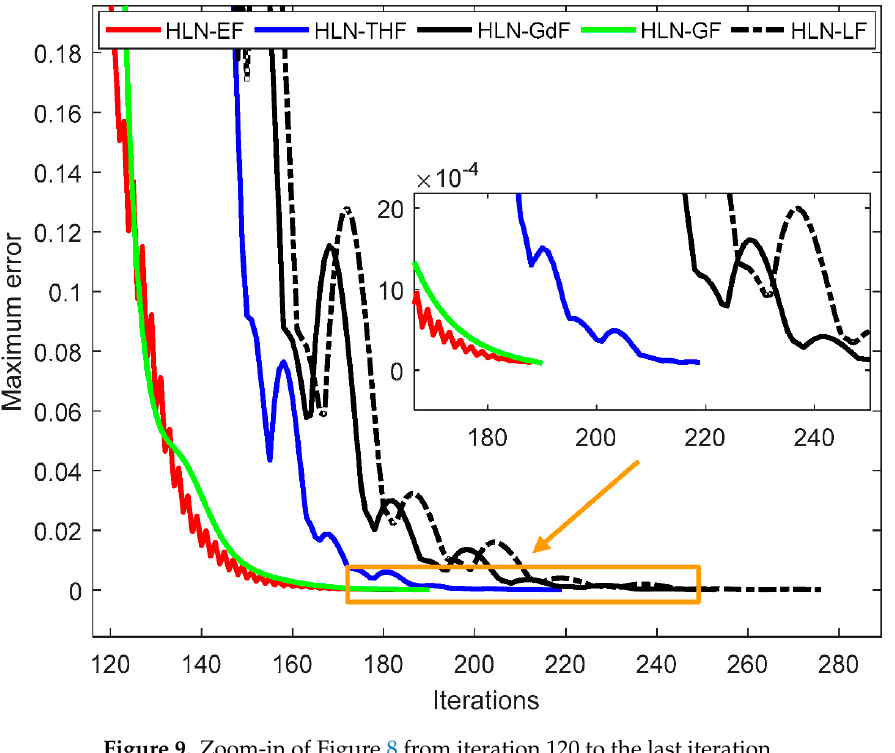
Figure 9. Zoom-in of Figure 8 from iteration 120 to the last iteration.